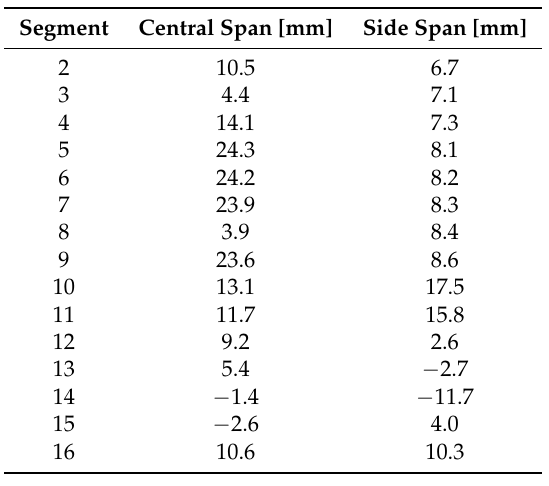
Table 1. Level corrections of segments used in the bridge construction (positive sign means an upward